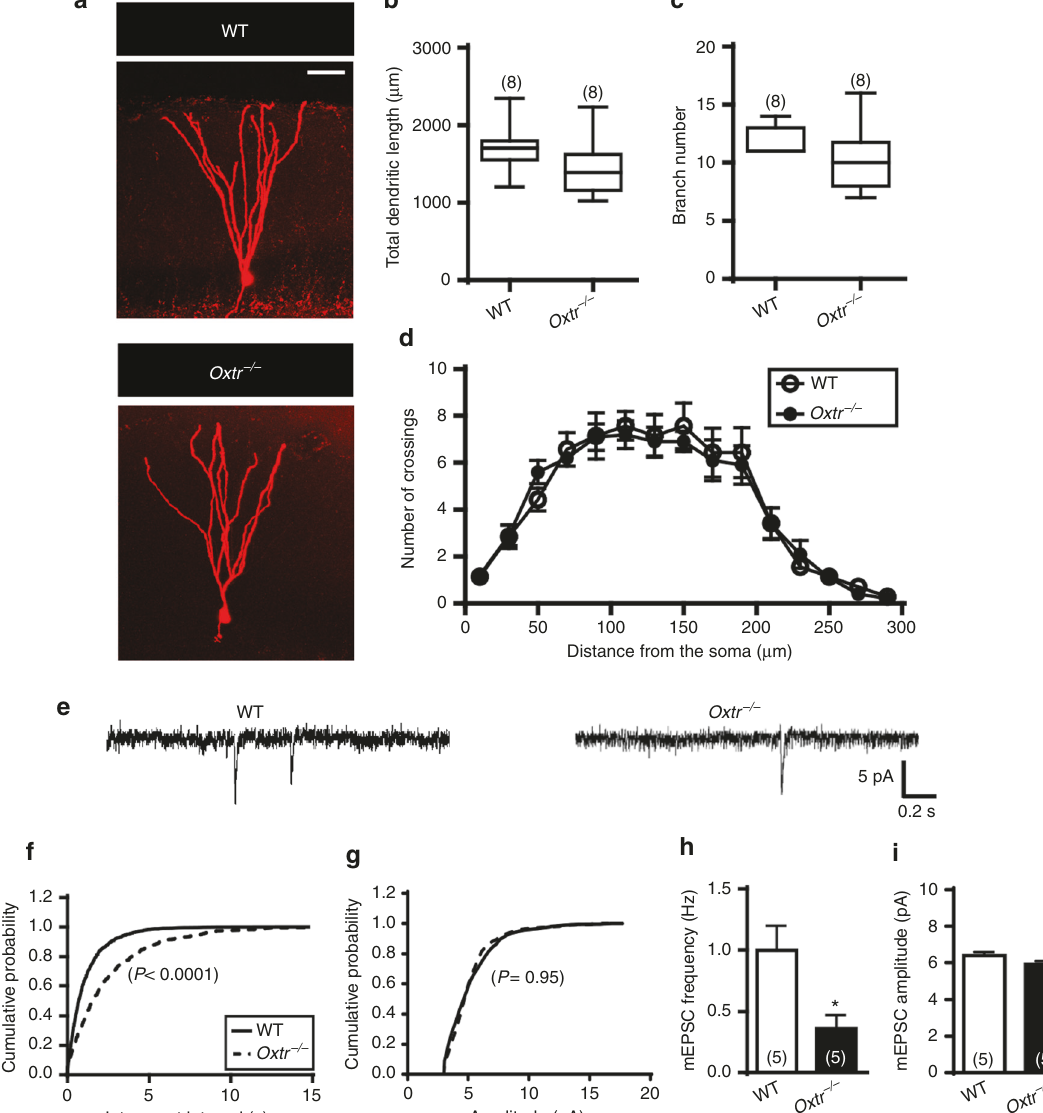
Fig. 6 Effects of Oxtr deletion on morphological features and excitatory synaptic transmission of mature DGCs. a Representative micrographs of biocytin- fi lled mature DGCs from WT and Oxtr − / − mice. Scale bar , 50 μ m. b , c Summary bar graphs depicting b the total dendritic length and c branch number of mature DGCs from WT and Oxtr − / − mice ( n = 8 neurons from 5 mice per genotype; unpaired two-tailed Student ’ s t test). d Sholl analysis of dendritic complexity of mature DGCs from WT and Oxtr − / − mice ( n = 8 neurons from 5 mice per genotype, two-way ANOVA). e Representative traces of mEPSCs recorded from mature DGCs in slices from WT and Oxtr − / − mice. f , g Cumulative probability plots of mEPSC f interevent intervals and g amplitude ( n = 5 neurons from 3 mice per genotype, Kolmogorov-Smirnov test) in mature DGCs from WT and Oxtr − / − mice. h , i Summary bar graphs depicting the averaged h frequency and i amplitude of mEPSCs in mature DGCs from WT and Oxtr − / − mice ( n = 5 neurons from 3 mice per genotype; * P < 0.05, unpaired two-tailed Student ’ s t test). Data represent the mean ±